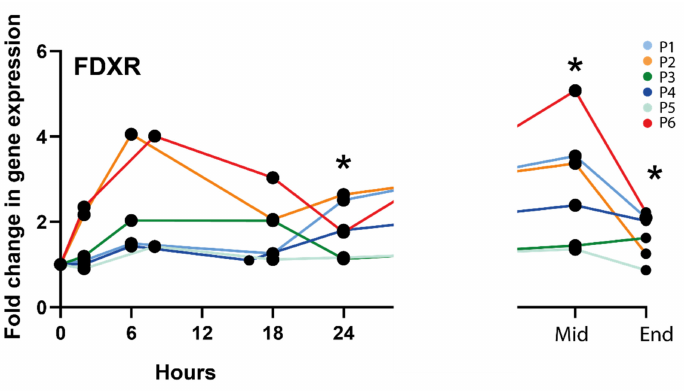
Figure 1. FDXR expression profile in all radiotherapy patients. * Significantly different from control (before treatment) (paired t test, p ≤ 0.05).